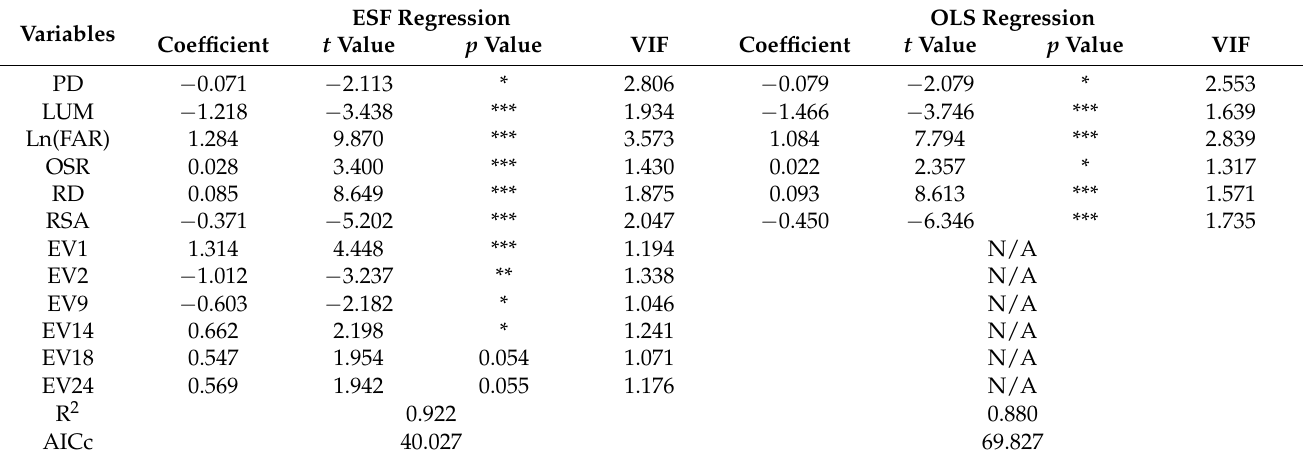
Table 5. Comparison of OLS regression and ESF regression (ln(Comp_V) as the dependent variable).